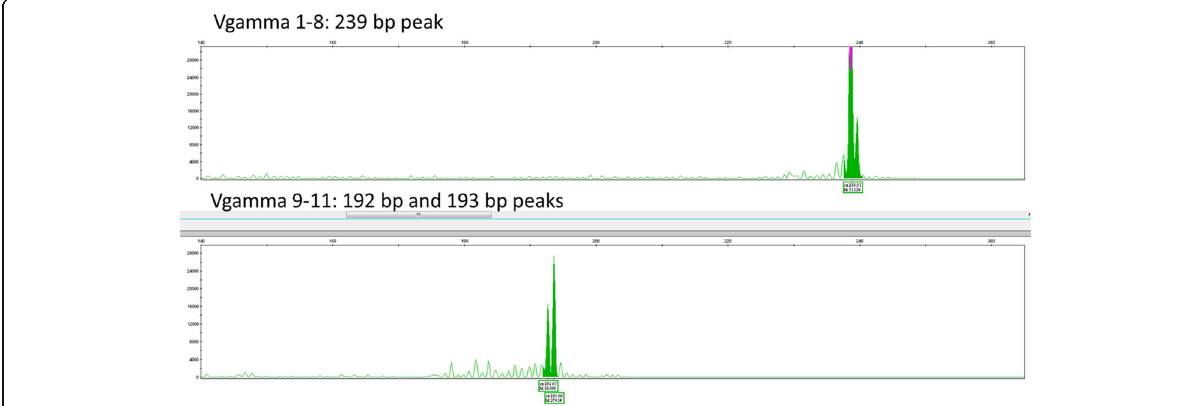
Fig. 4 T-cell receptor (TCR) gamma gene rearrangement studies by PCR performed on the nasal biopsy. The TCR gamma gene rearrangement studies revealed a monoclonal rearrangement with a 239 base pair peak in the V-gamma Reaction 1, and 192 and 193 base pair peaks in the V- gamma Reaction